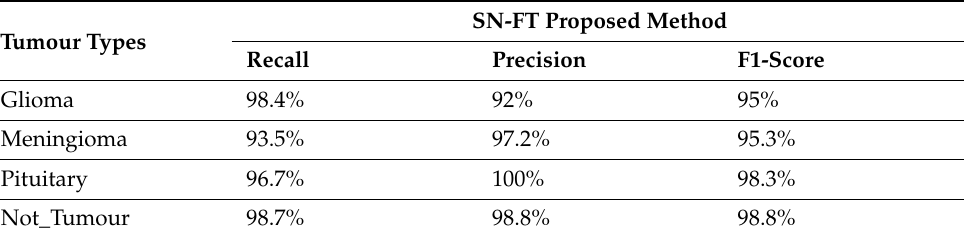
Table 3. Results of each type of tumour in the SN-FT proposed method.